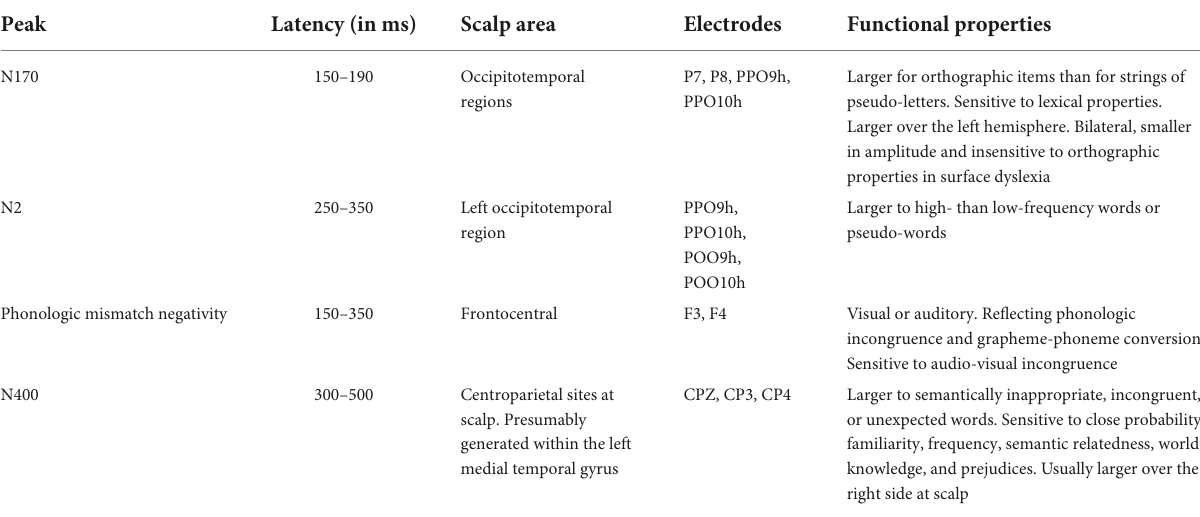
TABLE 3 Functional properties of orthographic N170 and major linguistic components according to the current ERP literature (Nobre and McCarthy, 1995; Kutas and Iragui, 1998; Helenius et al., 1999; Salmelin et al., 2000; Proverbio et al., 2004b, 2006, 2008; Simon et al., 2004; Lau et al., 2008; Kutas and Federmeier, 2009; Lewendon et al., 2020; Brusa et al.,